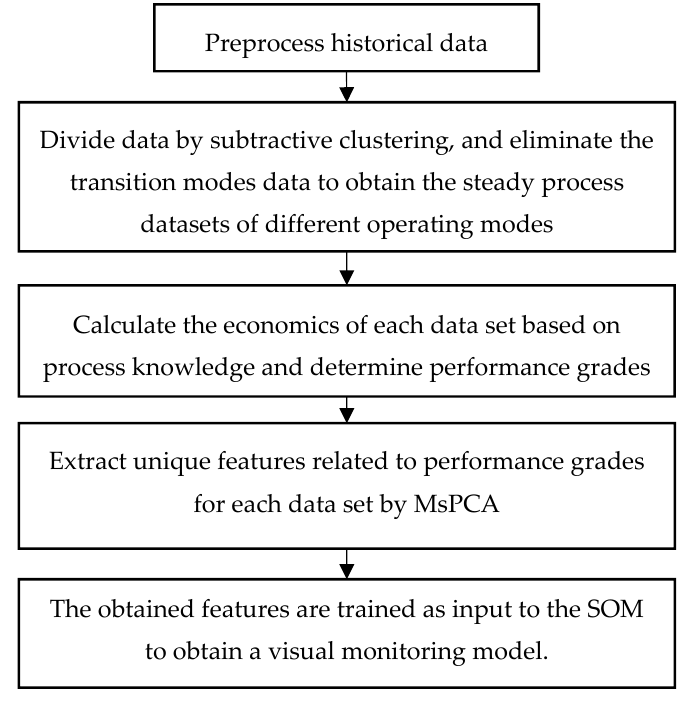
Figure 3. Training process of visual monitoring model for multi-modal operating conditions.